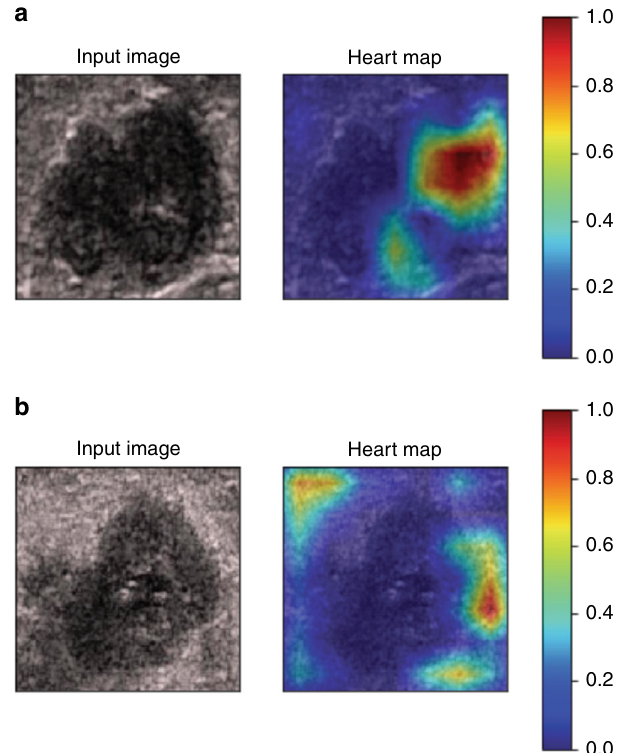
Fig. 5 Visualization of two patient examples. Each example shows the gray-scale US image and corresponding heart map, and the red region represents a larger weight, which can be decoded by the color bar on the right. Image a shows that the low echo area inside the tumor is valuable for predicting ALN status, while it is the tumor boundary for image b.